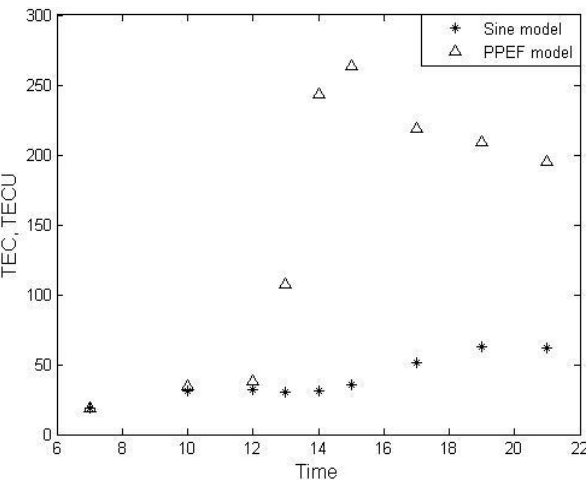
Fig. 3. The SAMI2-derived TEC at altitudes above 400km at ∼ 13:00LT and at 25 ◦ MLAT. The starred values are for a quiet time interval with a peak diurnal electric field of 0.53mVm − 1 at 07:00LT. The open triangles represent the TEC for the case of an electric field of 4mVm − 1 for a 2h duration. In the storm case, the TEC increases until a peak value of ∼ 270TEC units is reached. This closely matches the peak EIA observed by CHAMP during the third CHAMP pass shown in Fig. 2.